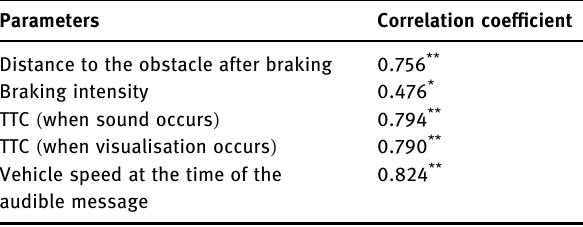
Table 12: Correlation of TTC ( when sound occurs ) with the rest of the parameters Parameters